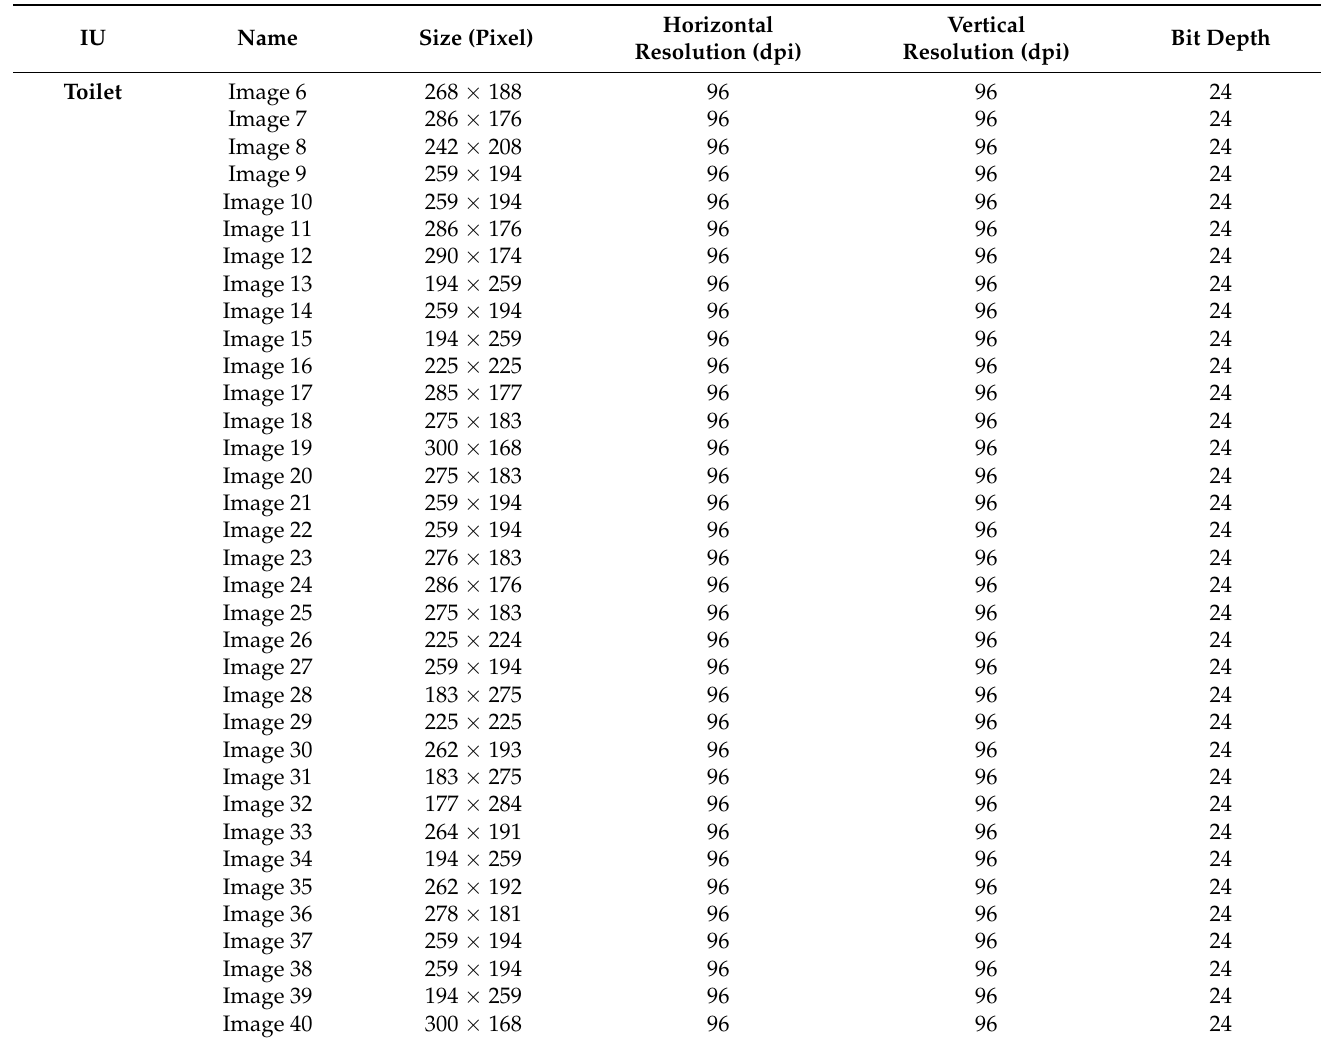
Table A8. Dataset used for the second version of the Detectron2 model (9